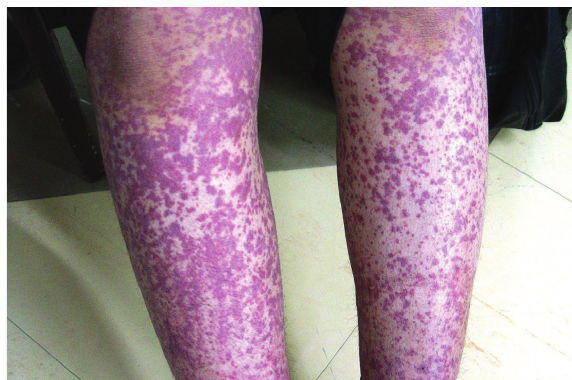
Figure 1: Palpable purpura with more intensity on the lower extremities.